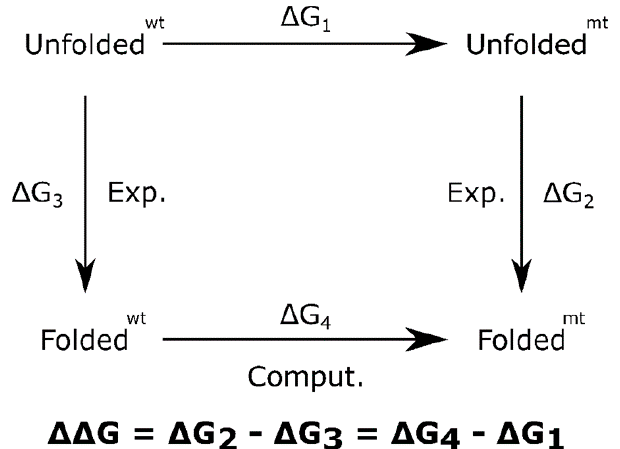
Figure 7. Thermodynamic cycle to calculate mutation free energy. Supplementary Materials: The following are available online at